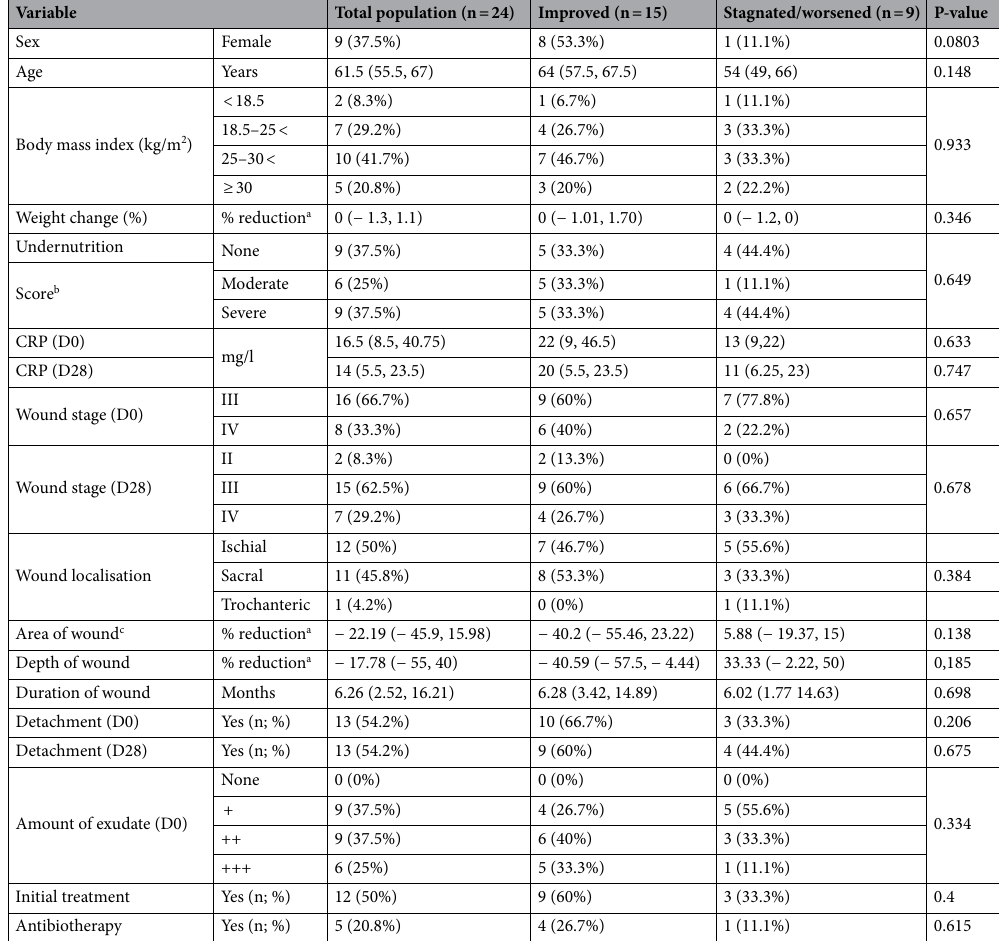
Table 1. Clinical data of included patients in total population and according to wound evolution (improved vs stagnated/worsened). Quantitative variables are expressed as median (Q1, Q3) and qualitative variables as absolute frequency (relative frequency in %). The statistical tests are either Student or Wilcoxon for quantitative variables and Chi-squared or Fisher’s exact for qualitative variables. a 100 × (D28-D0)/D0, b in accordance to 28 , c Kundin’s formula 29